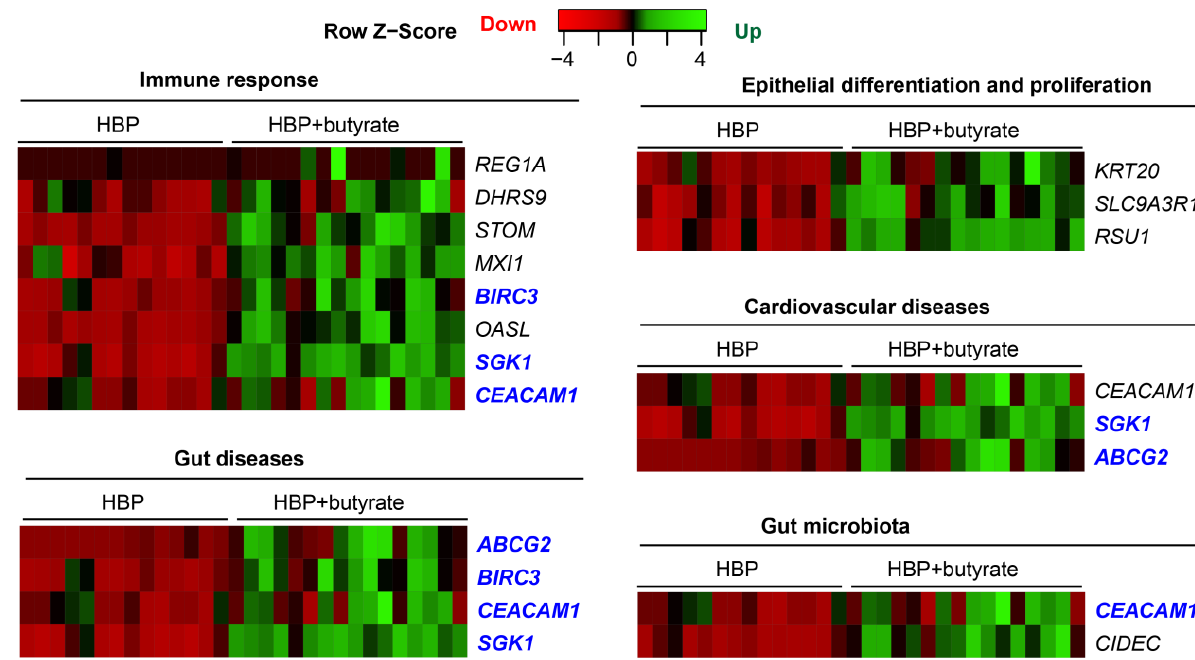
Figure 7. Butyrate rescues impaired gene expression of colonic organoids from HBP subjects with the annotated pathways or drug target information. Differentially expressed genes were shown using supervised hierarchical clustering in Heatmapper with FDR-corrected p < 0.05, upregulated (red) gene and downregulated (green) gene in HBP organoids vs. HBP organoids treated with butyrate. Blue-highlighted genes were the potential drug targets.